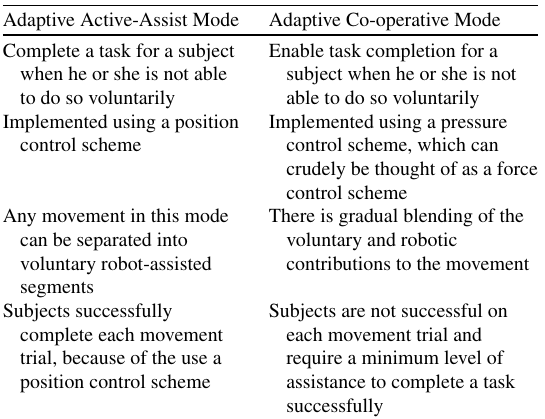
Table 4 Comparison of AAM and